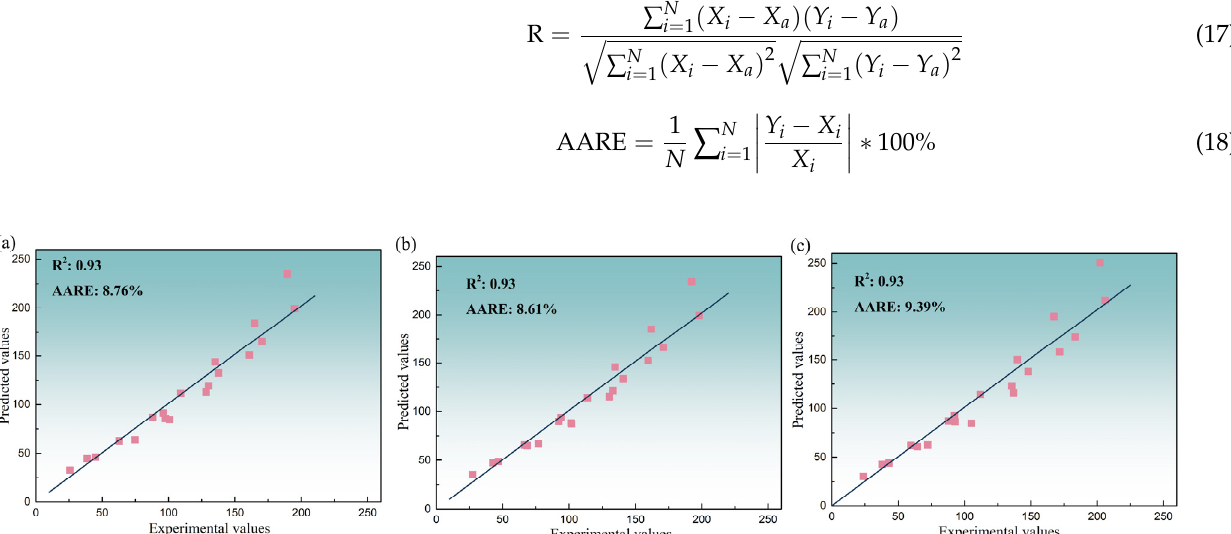
Figure 8. Comparison of the predicted and experimental flow stresses (Arrhenius-type constitutive equation) ( a ) AA5182, ( b ) AA5182 − 0.05Sc − 0.1Zr, and ( c ) AA5182 − -0.1Sc − 0.1Zr. equation) ( a ) AA5182, ( b ) AA5182 − 0.05Sc − 0.1Zr, and ( c ) AA5182 − 0.1Sc −